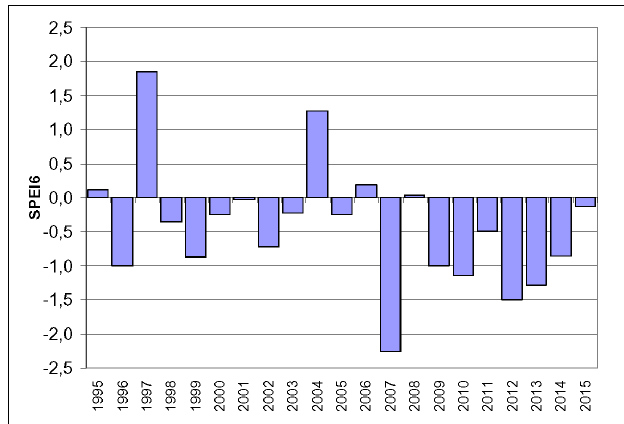
FIGURE 2 | Time series of the SPEI at 6-months time scale (April–August) during